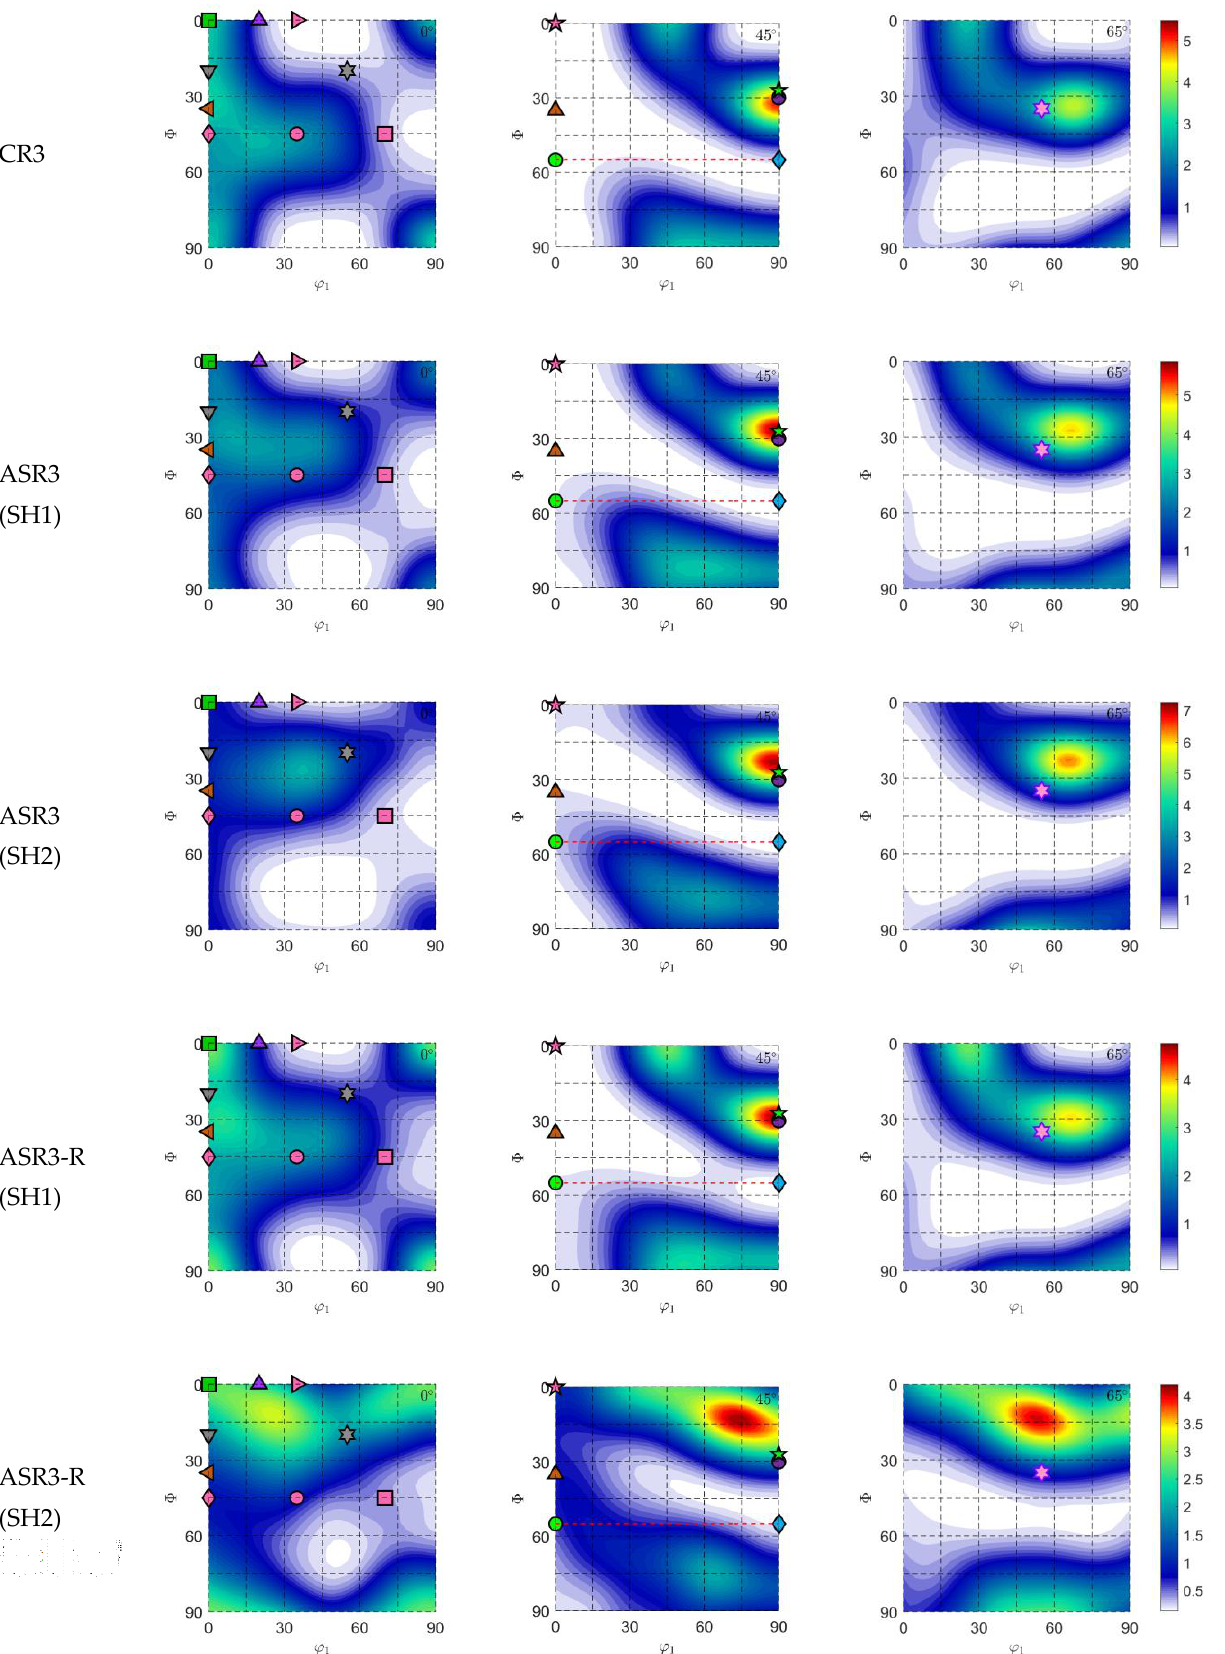
Figure A5. ODF sections for the third pass with a 20% thickness reduction per